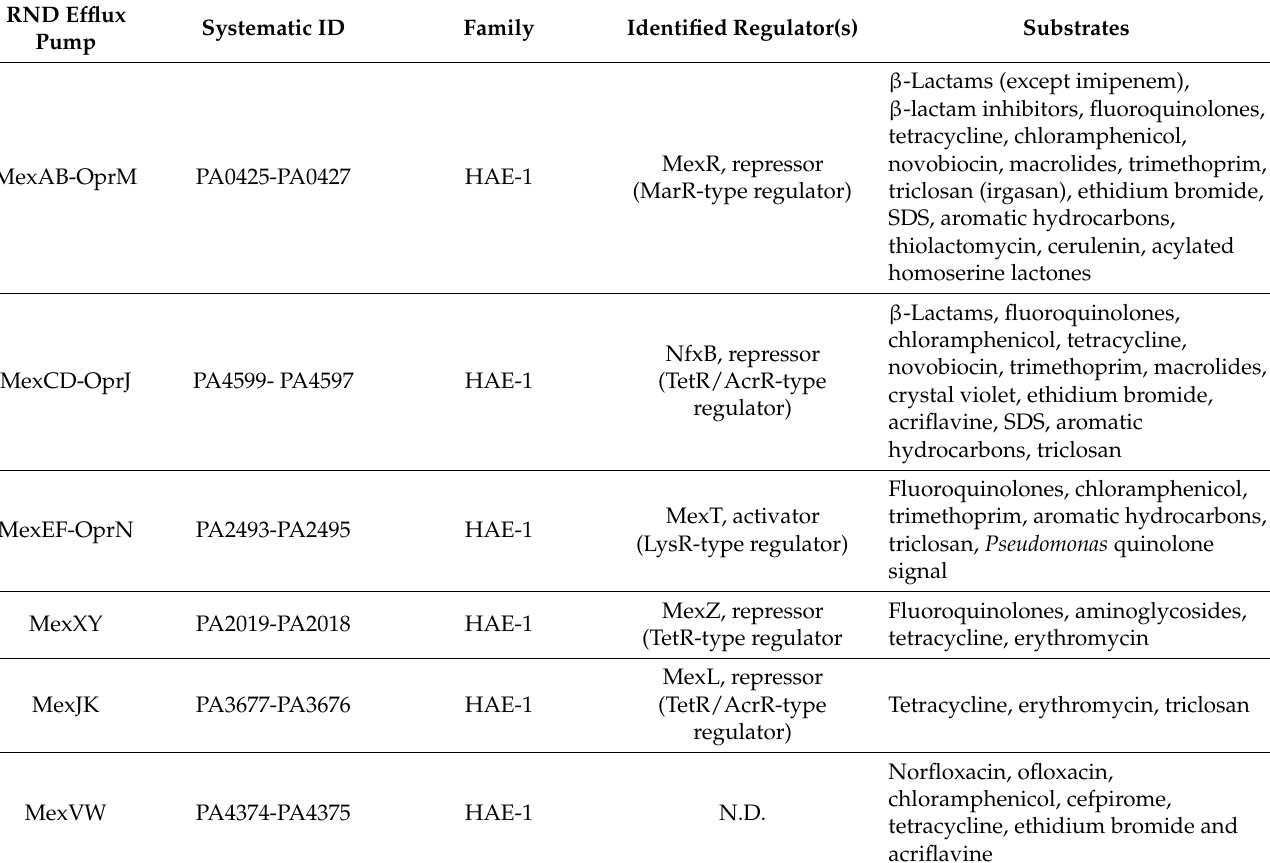
Table 1. RND efflux pumps in P. aeruginosa